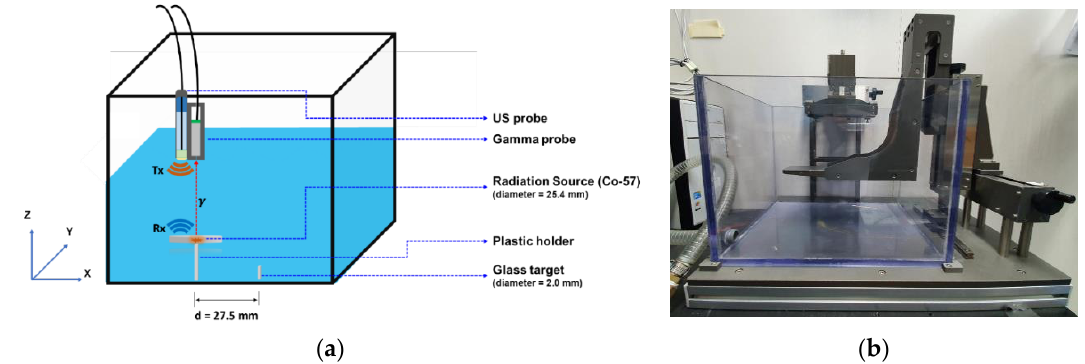
Figure 4. ( a ) Illustration of the experimental setup of the water tank in which a disk-type radiation source (Co-57) and a glass target were placed for experimental data acquisition. The targets were then scanned using the hybrid US-gamma probe. ( b ) Custom 3-axis moving stage for manipulating the hybrid probe across the water tank.